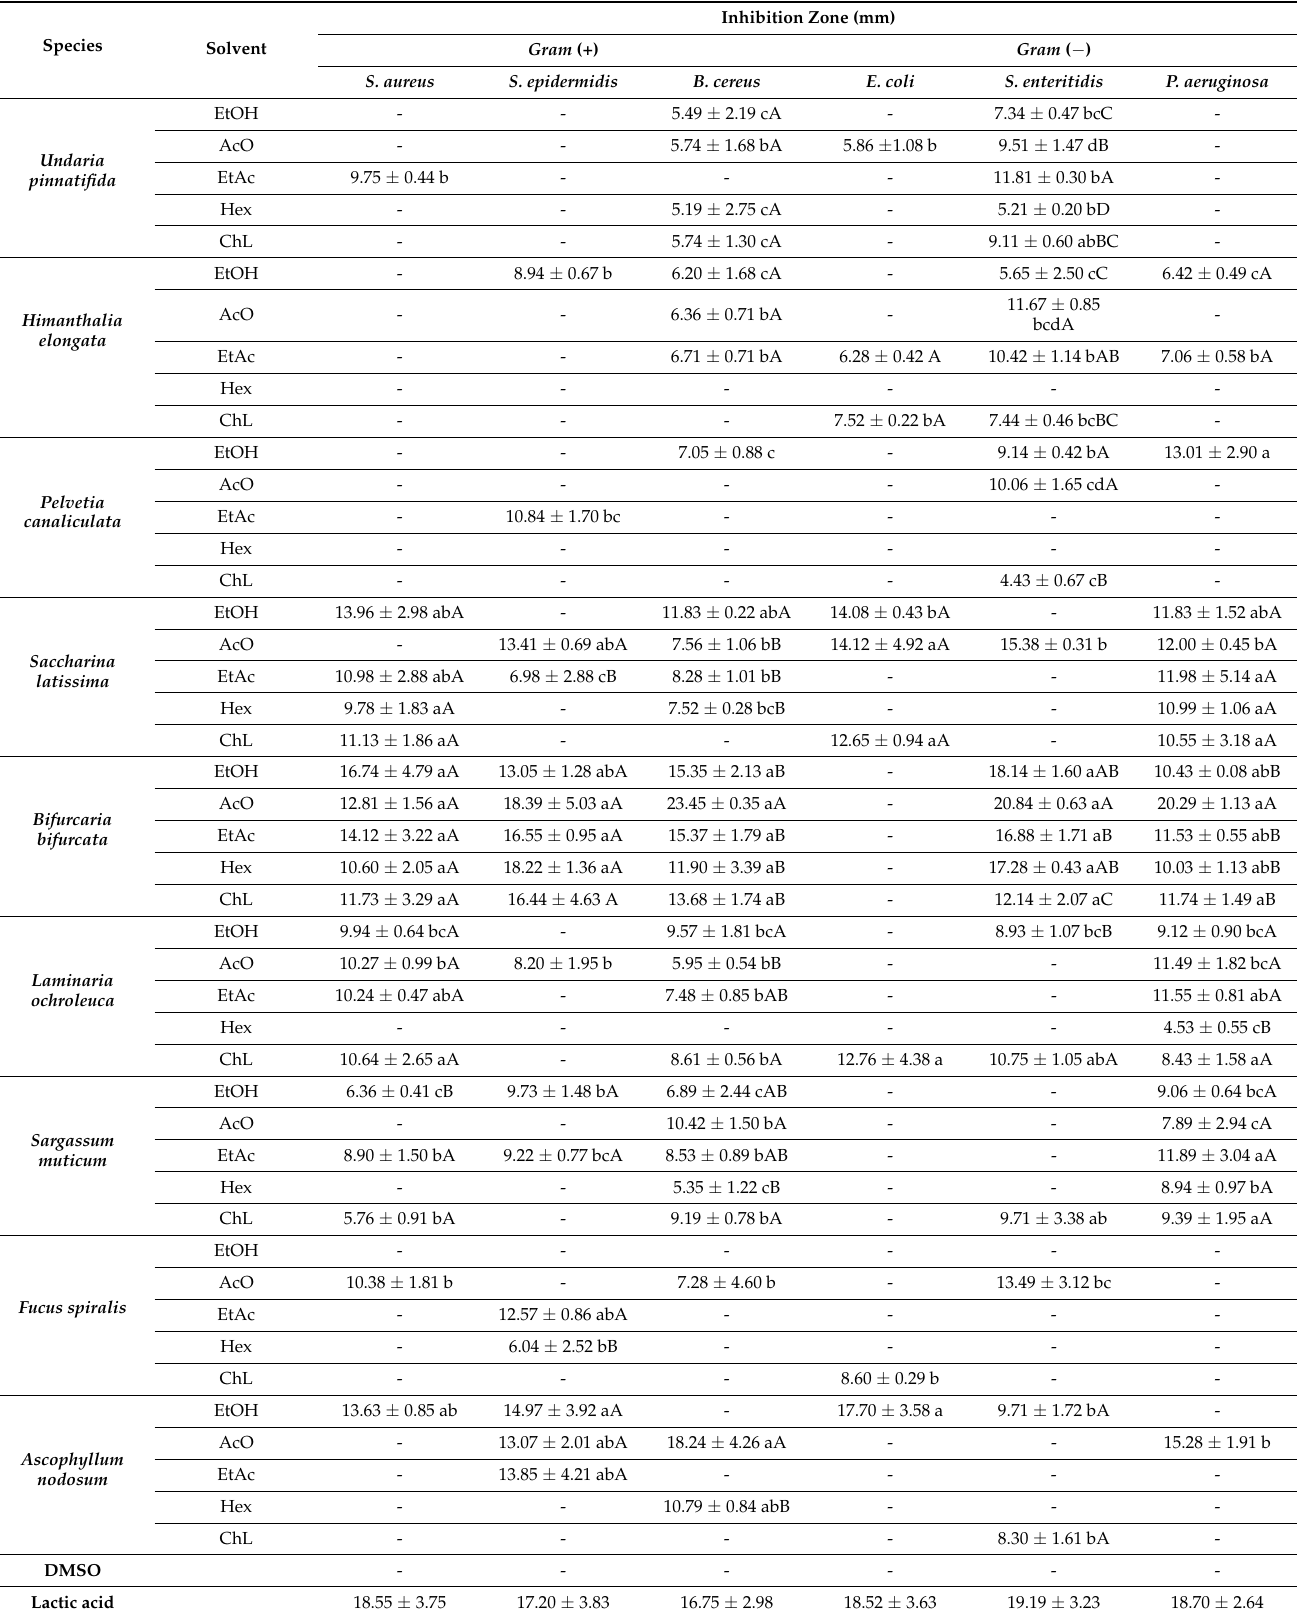
Table 2. Average diameter of inhibition zone ± standard deviation (mm) of brown algae extracts positive and negative controls 1 .